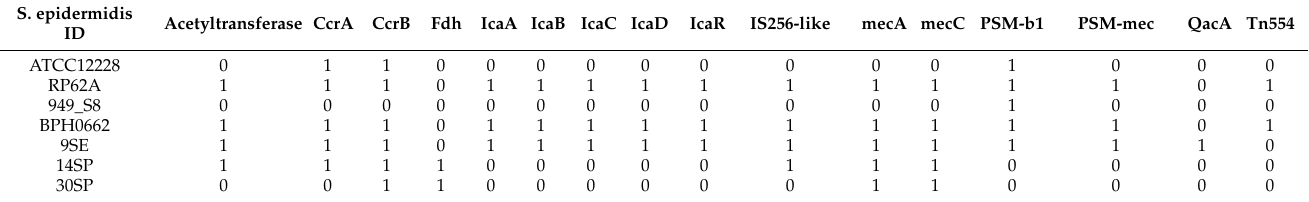
Table 3. Presence of genes among S. epidermidis isolates (9SE, 14SP, and 30SP) and reference strains